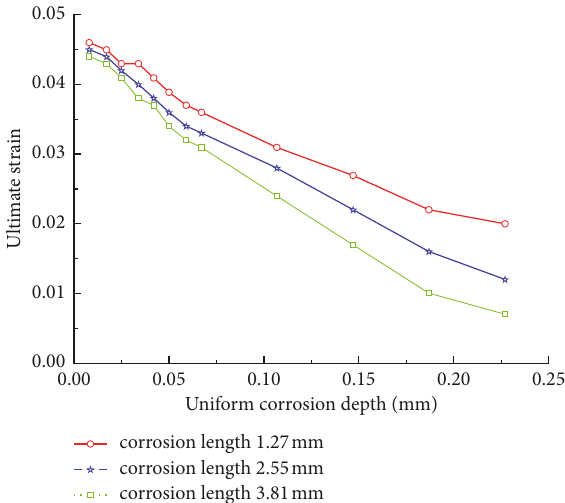
Figure 8: Influence of uniform corrosion depth on ultimate strain of steel wire.